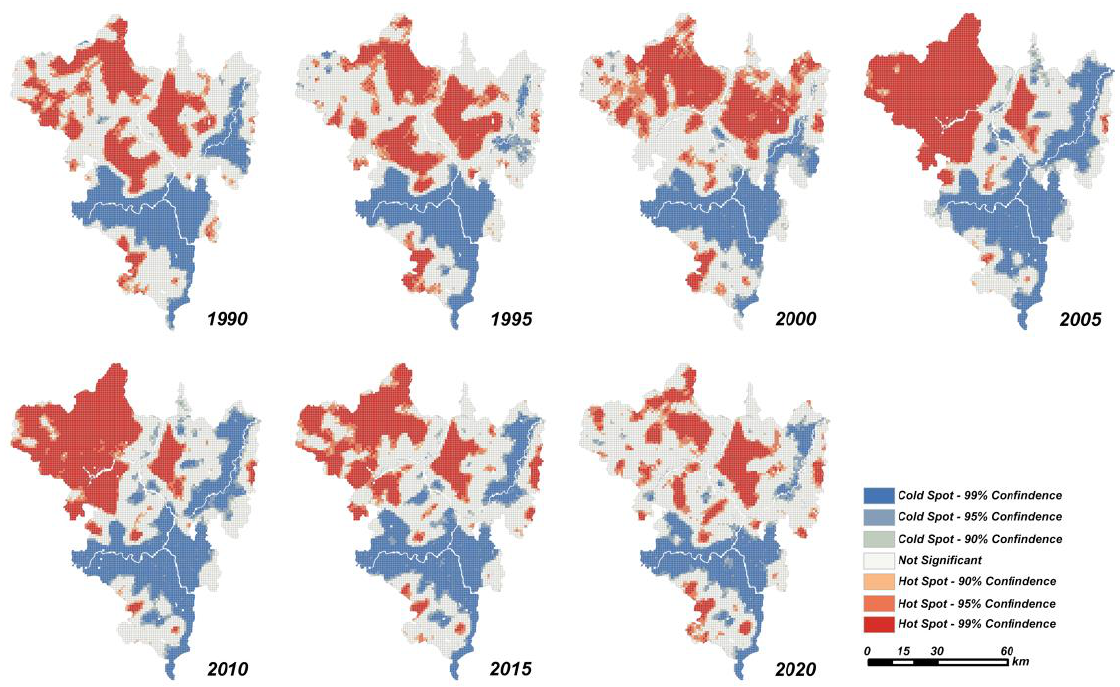
Figure 6. Scatterplot of RSEI Moran ’ s I in Panzhihua in 1990, 1995, 2000, 2005, 2010, 2015, and 2020.